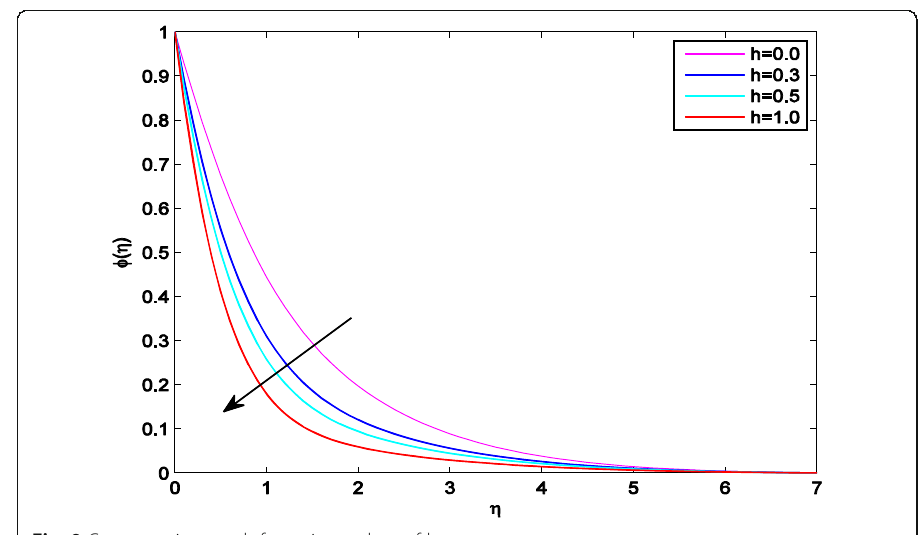
Fig. 9 Concentration graph for various values of h